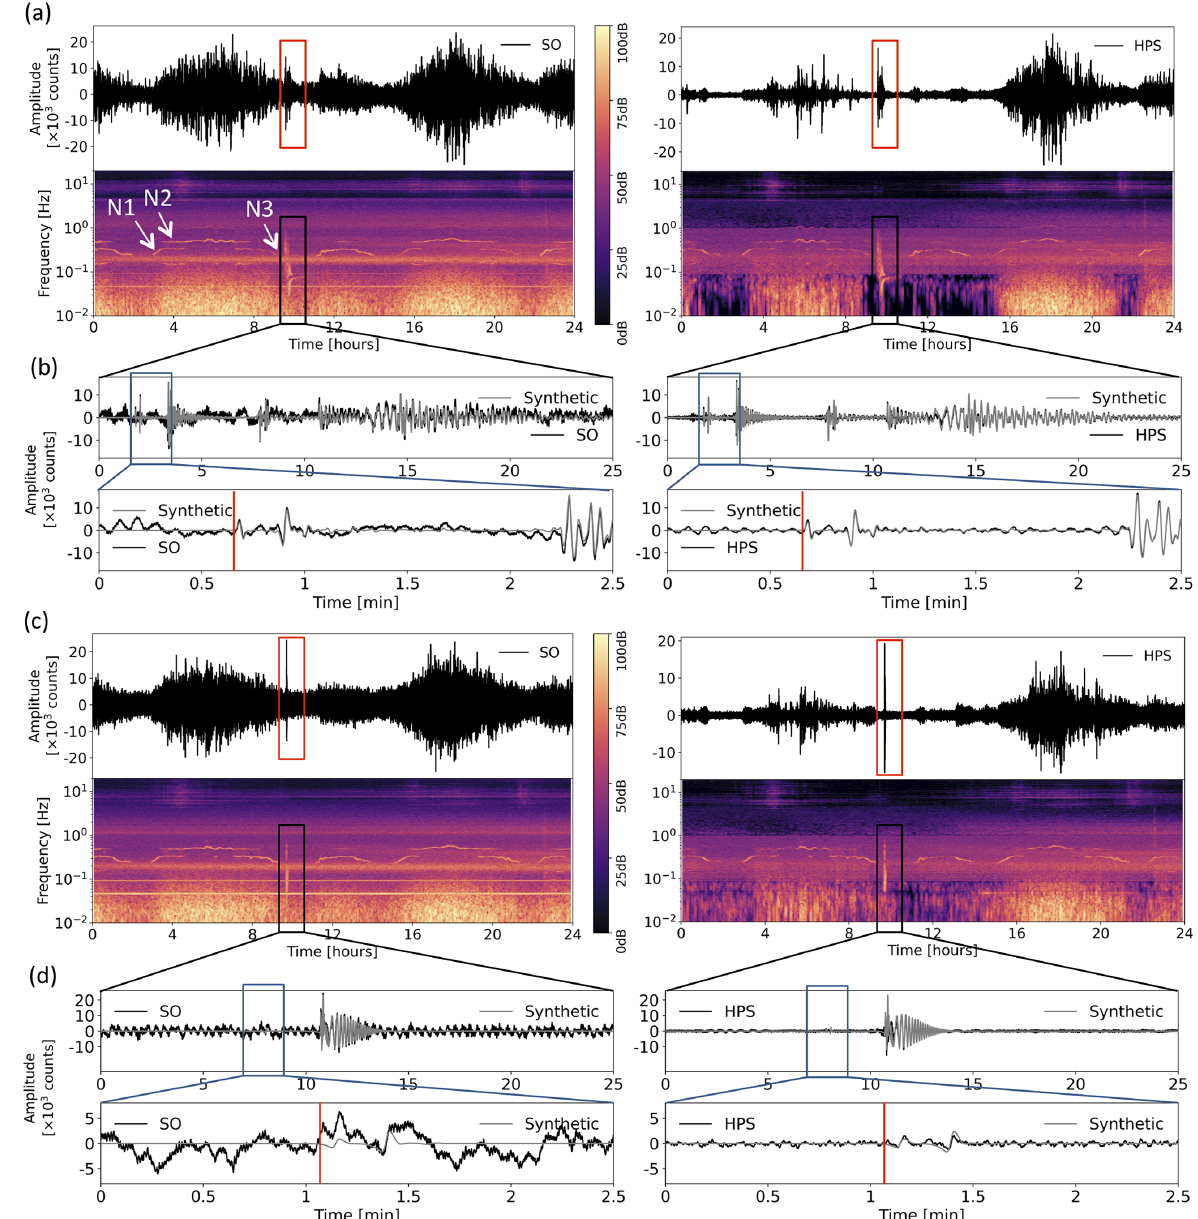
Figure 3. Comparison of the synthetic seismograms and spectrograms of the original signal SO and the HPS noise-reduced signal on the R and T components for a synthetic signal with SNR = 1.5 before denoising. Panels (a) and (c) show 1d seismograms and spectrograms for R and T components, respectively. Squares show the earthquake section. The arrows in (a) show three noise situations (N1–N3). Panels (b) and (d) show seismograms of the earthquake section on SO and HPS signals, with a detailed view of the P arrival (on component R in b ) and SH arrival (on component T in d ). Red lines show P arrivals in (b) and SH arrival in (d)